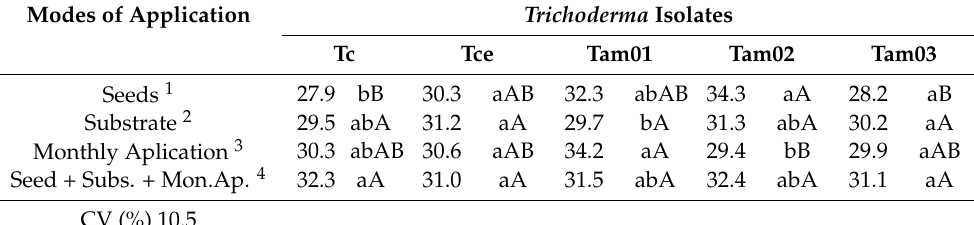
Table 3. Height of Theobroma cacao seedlings in relation to different modes of application modes of Trichoderma spp., six months after